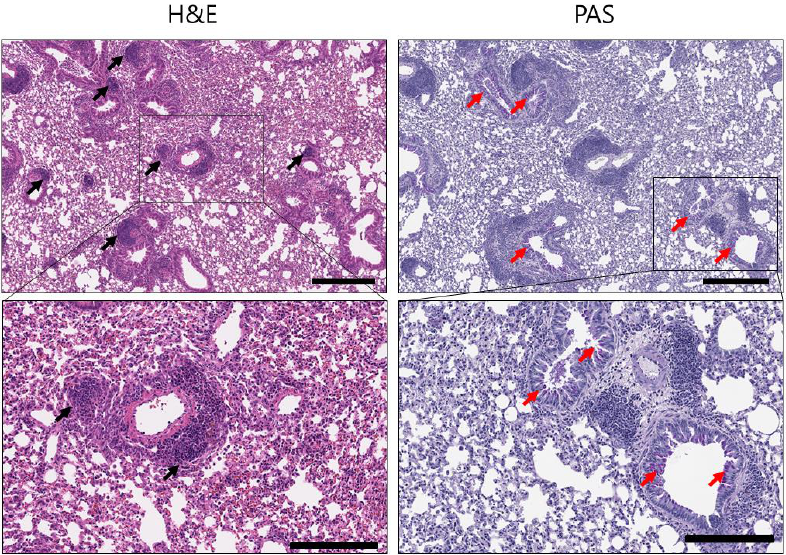
Figure 7. Histological analysis of the effects of blank PLGA-DPPs on OVA-induced asthmatic mice. Representative H&E-stained ( left panel ) and PAS-stained ( right panel ) sections of the lungs. Black arrows in the H&E staining image indicate the infiltration of inflammatory cells. Red arrows in the PAS staining image indicate PAS-positive goblet cells. The scale bars represent 400 µm ( upper panel ) and 200 µm ( lower panel ).